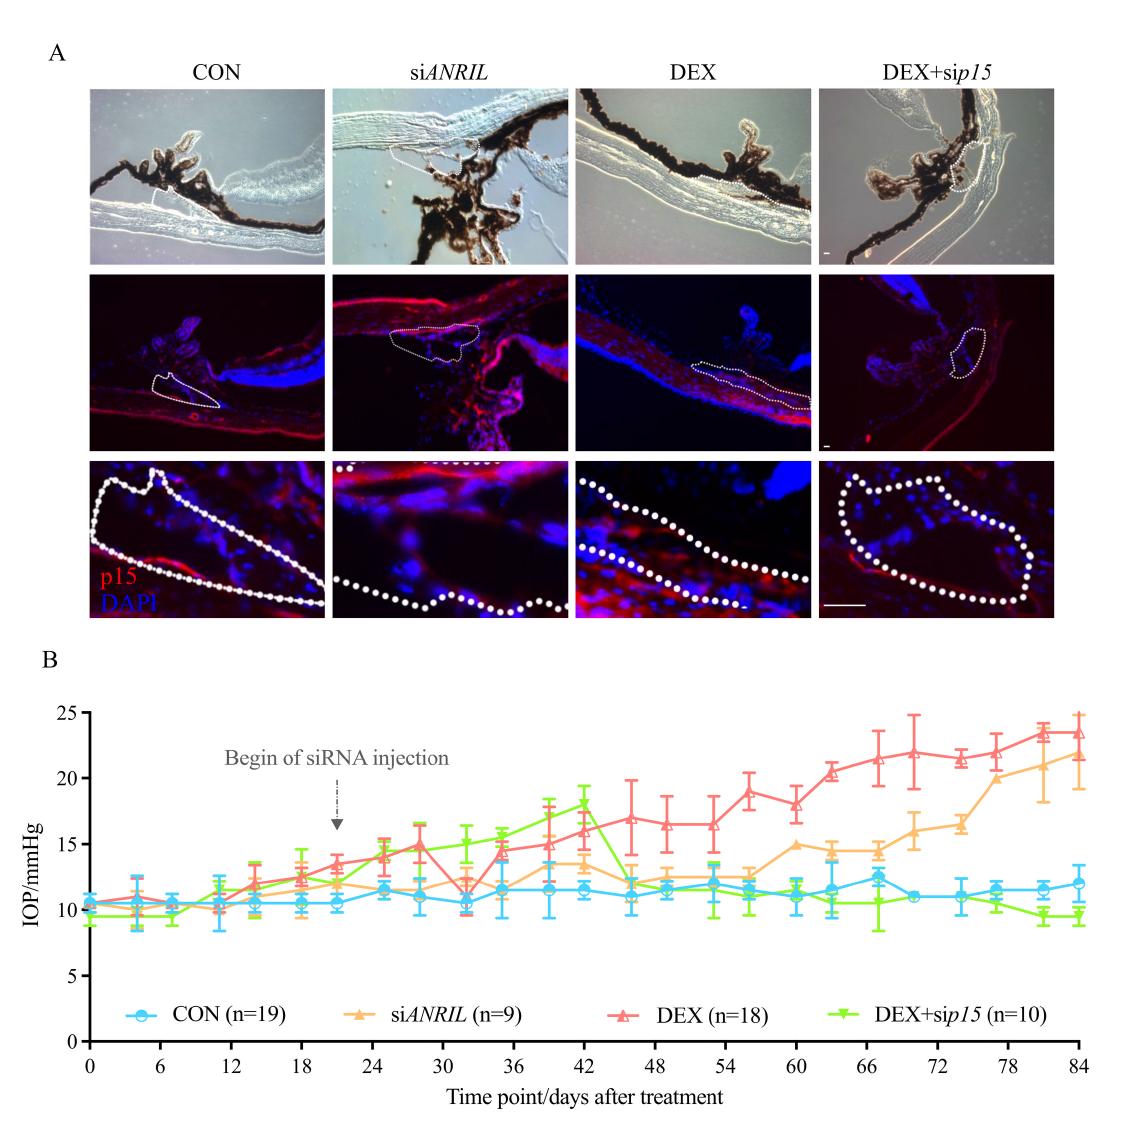
Figure 5. ANRIL/p15 promotes SIG in mice models. ( A ) The expression of p15 protein accumulated in mice anterior segment samples after exposure to DEX. p15 knockdown decreased p15 intraocular protein amount. The p15 level in the DEX + sip15 group was comparable to the control mice, suggested by IF. TM region is outlined with white dashes. n = 5 per group. ( B ) The IOP significantly increased in DEX-treated mice, starting from 15.3 mmHg at 4 weeks and continually increasing to 23.4 mmHg at 12 weeks. Intraocular ANRIL depletion presented a consistent increased IOP pattern (IOP = 22.1 ± 0.89 mmHg at 12 weeks, compared with control mice, p < 0.05). When p15 was knocked-down, IOP elevated in the very beginning period with DEX exposure (0–6 weeks) and then continually recovered to a normal level. Arrow indicates the starting of intracameral siRNA delivery on Day 21. Notes: CON = control; siANRIL = ANRIL knock-down; DEX = dexamethasone; sip15 = p15 knock-down. Scale bar = 10 µ